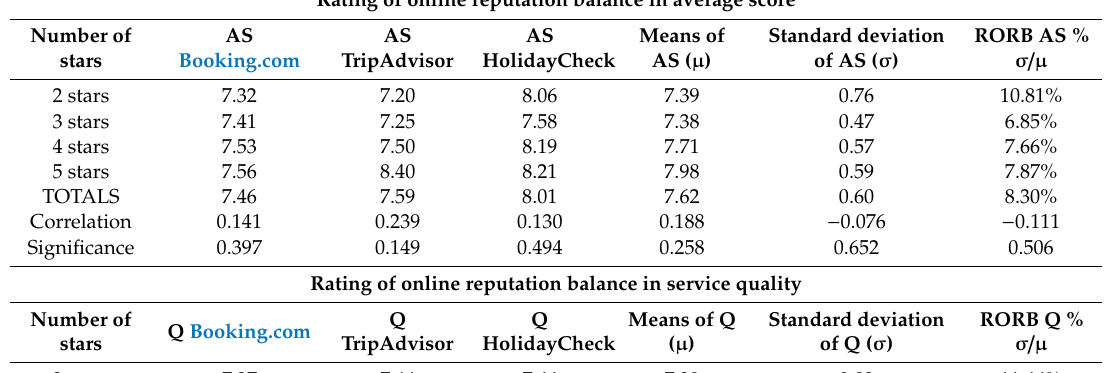
Table 3. Rating of online reputation balance in Agadir destination. Rating of online reputation balance in average